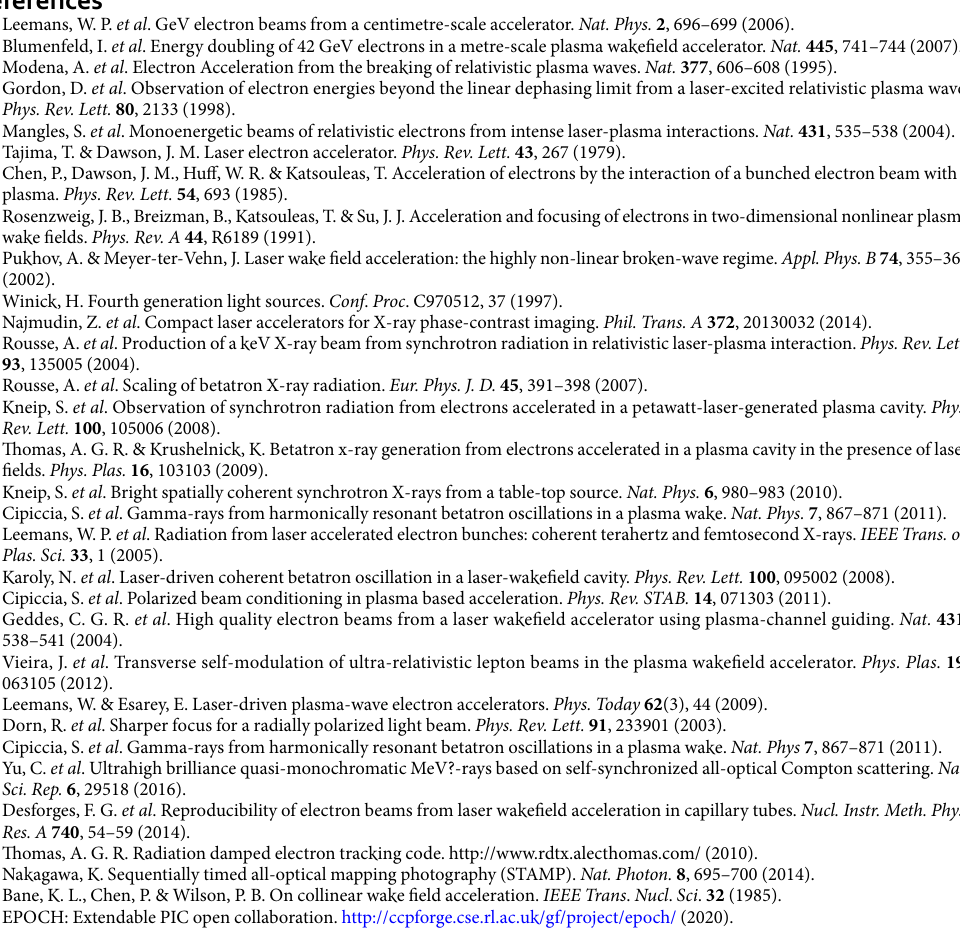
This quantity is the number of photons per 0.1% bandwidth per milliradian squared. To find the peak brilliance one has to divide by the intrinsic source properties of the electron beam generating the pulse, the duration, τ , and 2 , measured in millimetres squared (this convention adds a factor of 10 6 to the co-efficient to the the source area, σ r right have side of equation 7).